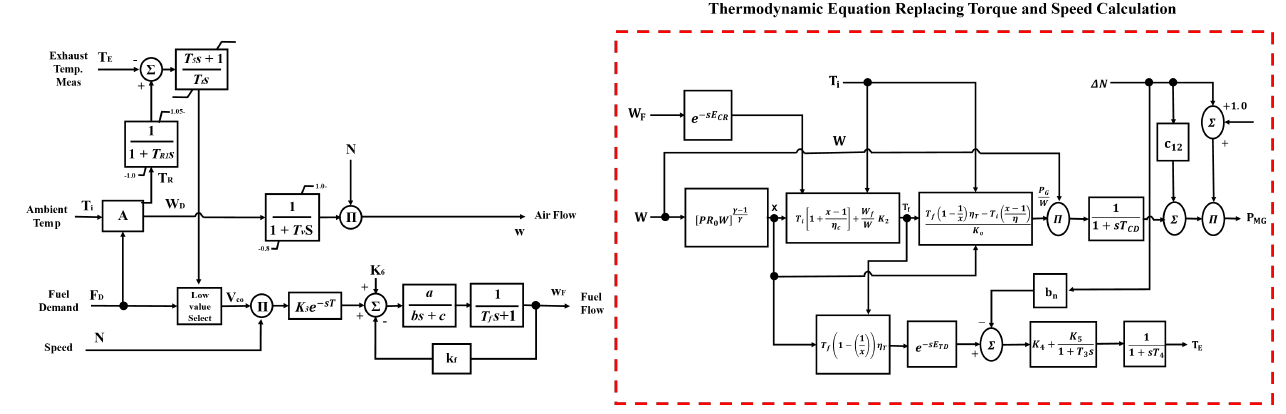
Figure 8. IEEE Gas turbine model for stability studies